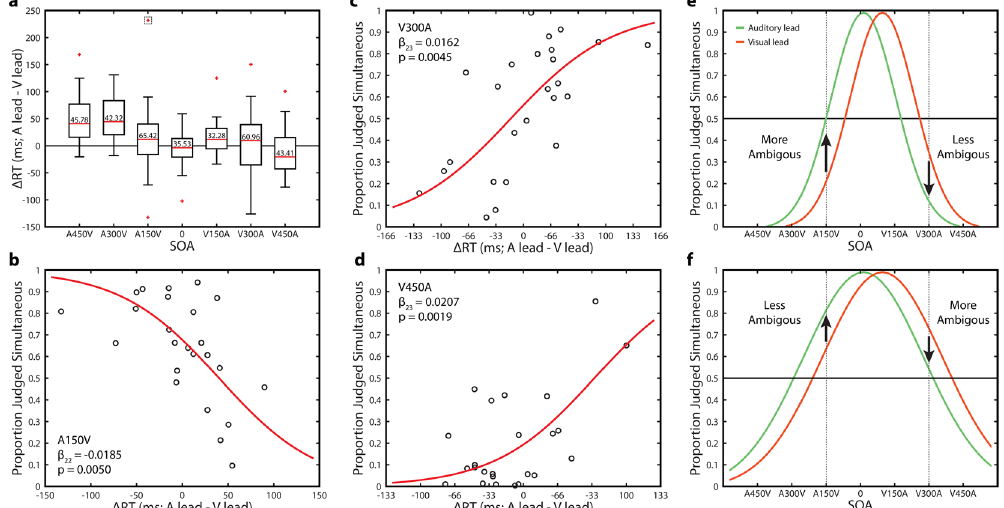
Figure 2. Effects of Rapid Recalibration on Response Time are Individualized. ( a ) Change in response time (A lead RT – V lead RT) for all SOAs. Inset numbers are the standard deviation of the change in response time. The dotted box indicates an outlier value not shown in panel B. ( b ) Correlation between change in response time (A lead RT – V lead RT) and participant mean perception rate pooled across lead types for the A150V condition. A single outlier was omitted (see main text for statistics with the outlier included). ( c ) Correlation between change in response time (A lead RT – V lead RT) and participant mean perception rate pooled across lead types for the V300A condition. ( d ) Correlation between change in response time (A lead RT – V lead RT) and participant mean perception rate pooled across lead types for the V450A condition. ( e ) Illustration of the effect of lead type on perceptual ambiguity for a participant with a narrow binding window. Relative to a visual lead, auditory leading trials are more perceptually ambiguous in the A150V condition, but less ambiguous in the V300A condition. The PSS for each distribution is identical to panel F. ( f ) Illustration of the effect of lead type on perceptual ambiguity for a participant with a wide binding window. Relative to a visual lead, auditory leading trials are less perceptually ambiguous in the A150V condition, but more ambiguous in the V300A condition. The PSS for each distribution is identical to panel